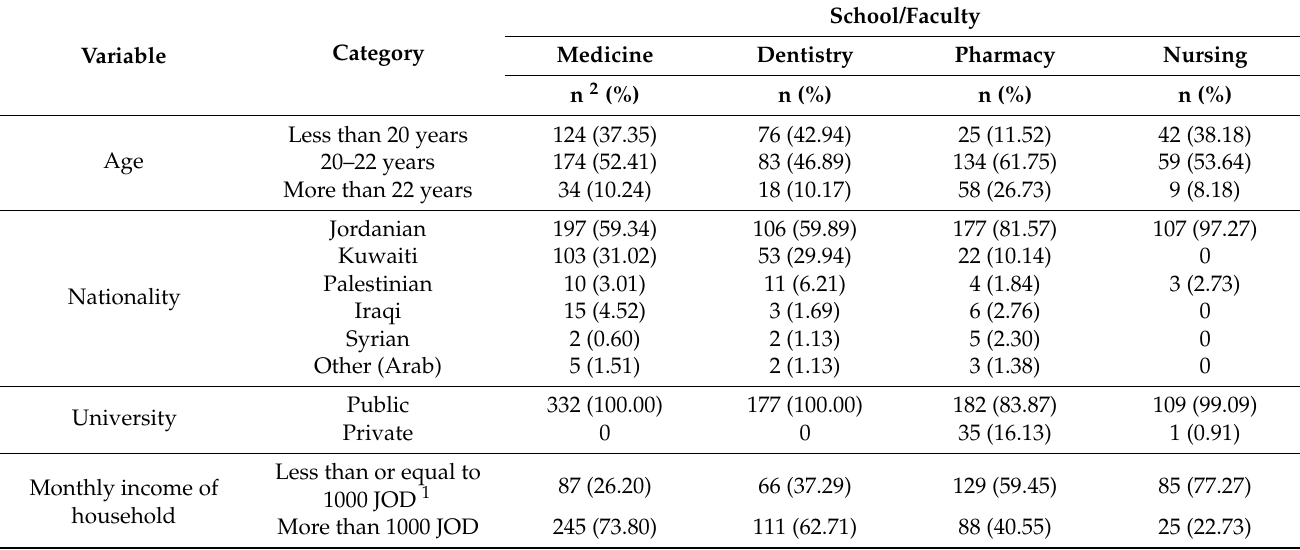
Table 1. General features of the study participants divided by